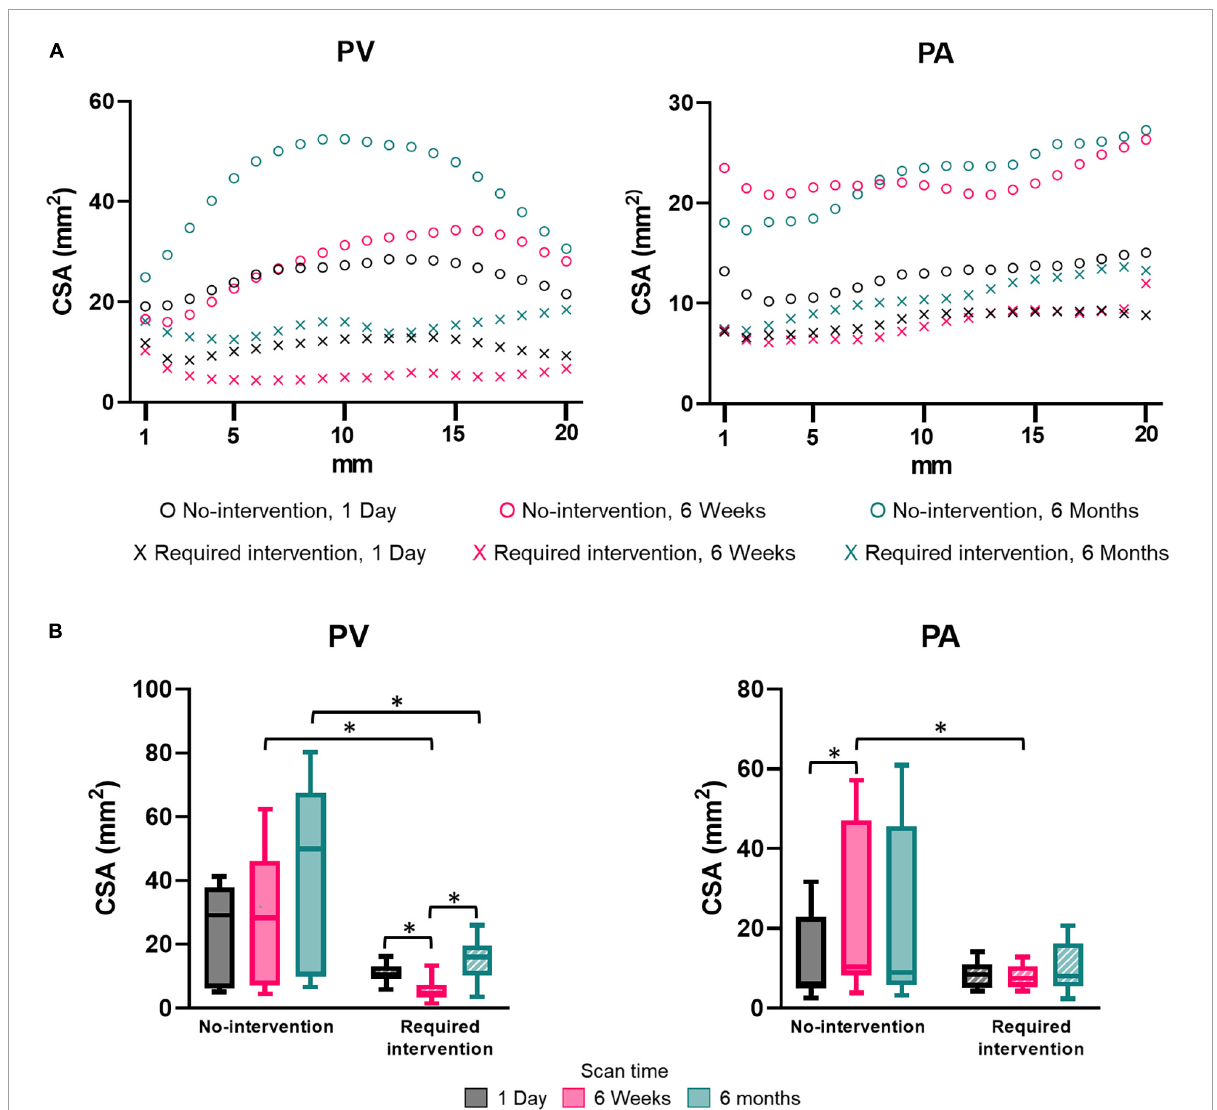
FIGURE2 Cross-sectional area (CSA) of the proximal vein (PV) and proximal artery (PA). (A) CSA by distance away from the anastomosis at an increment of 1 mm. Each marker shows the average of three patients. (B) CSA for the "no intervention" and "required intervention" groups at 1 day, 6 weeks, and 6 months. CSA was averaged over the distance of 20 mm starting from anastomosis, as seen in (A) . The box and whisker graph shows the 25th to 75th percentiles within the box, with the line in the middle of the box as the median and the whiskers extending to the minimum and maximum values. * P <